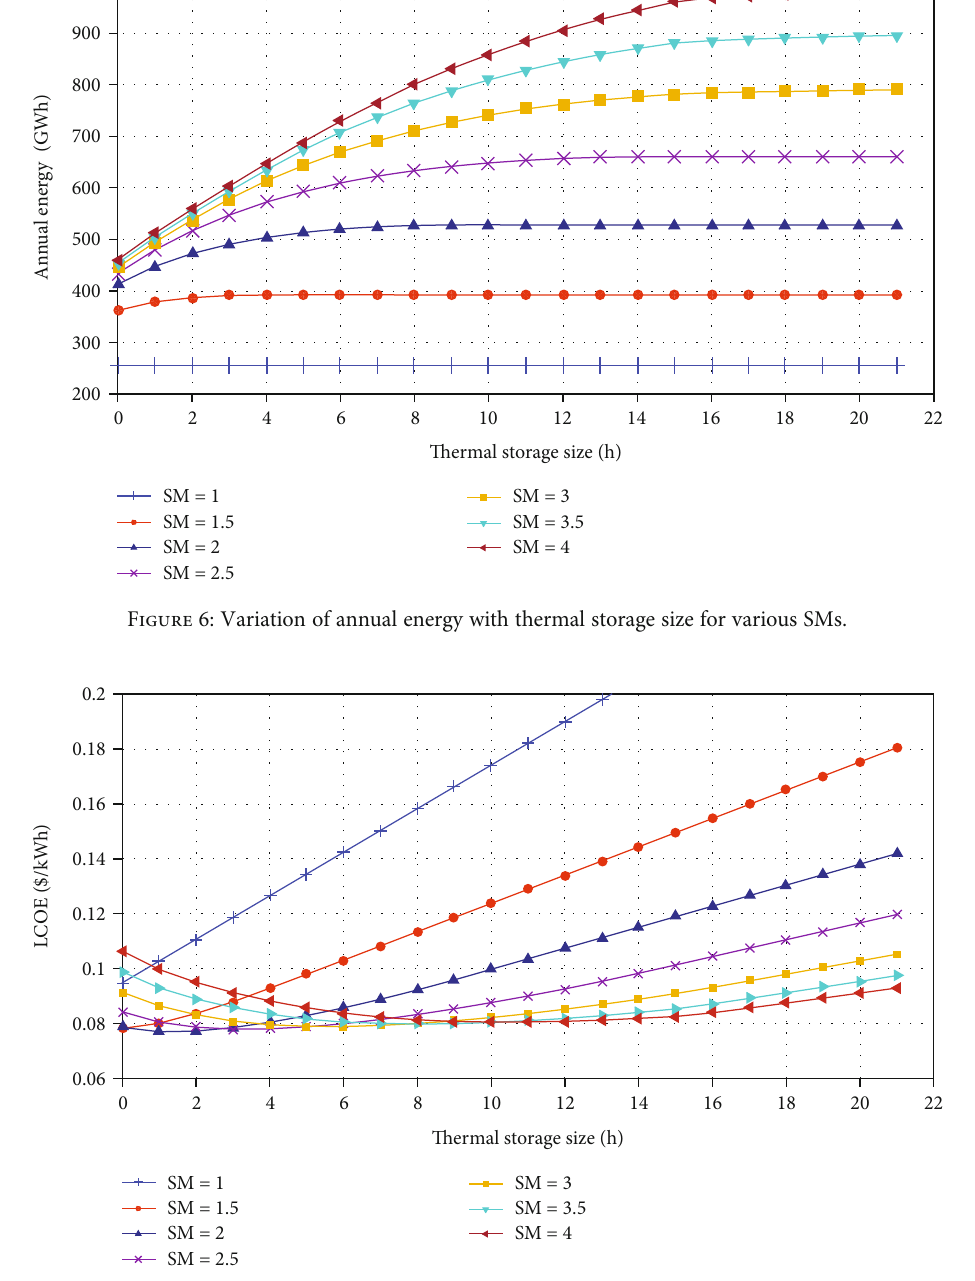
Figure 7: Variation of LCOE with thermal storage size for various SMs. Table 4: Summarization of optimal results of each